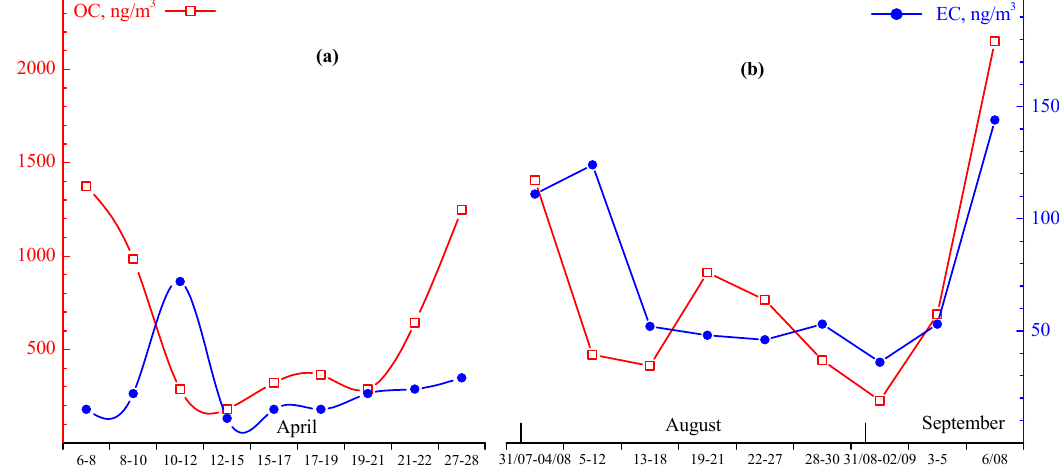
Figure 10. Variations in OC and EC concentrations in expedition of RV Akademik Tryoshnikov ( a ) and Professor Multanovskiy ( b ).